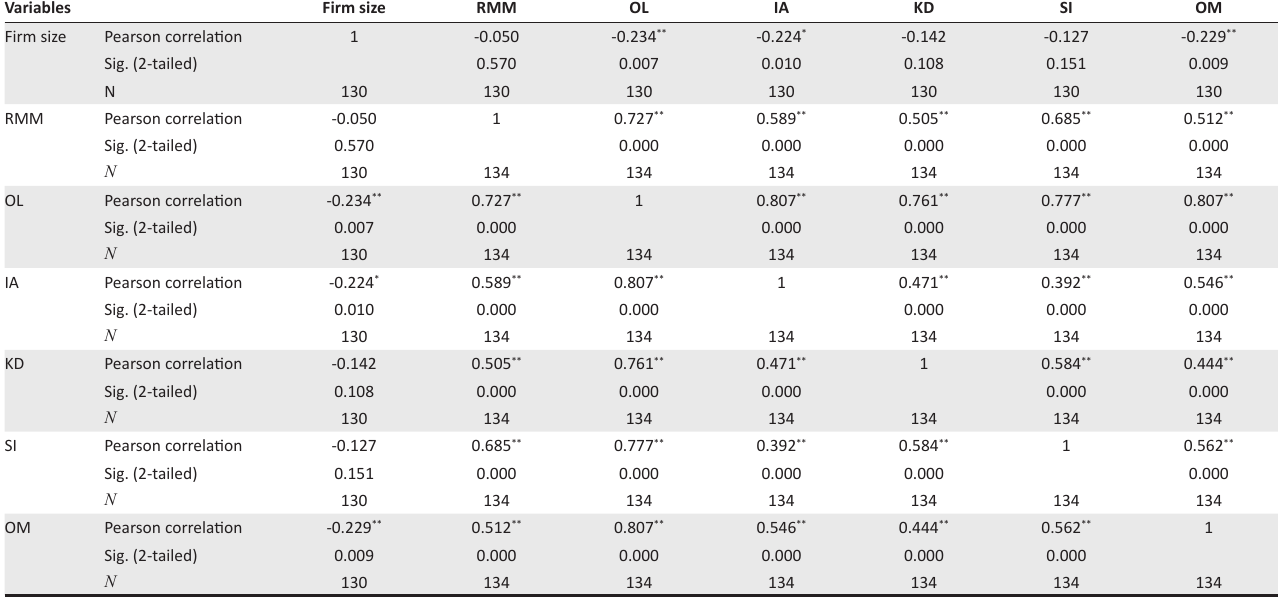
TABLE 3: Result of correlation among firm size, risk management maturity, organisation learning and organisation learning dimensions. Variables Firm size RMM OL Firm size Pearson correlation